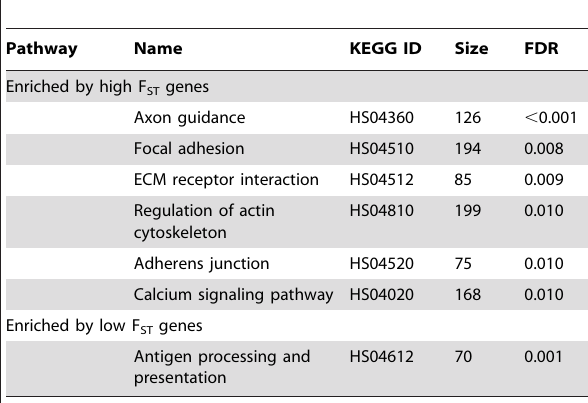
Table 1. Enriched KEGG pathways identified by